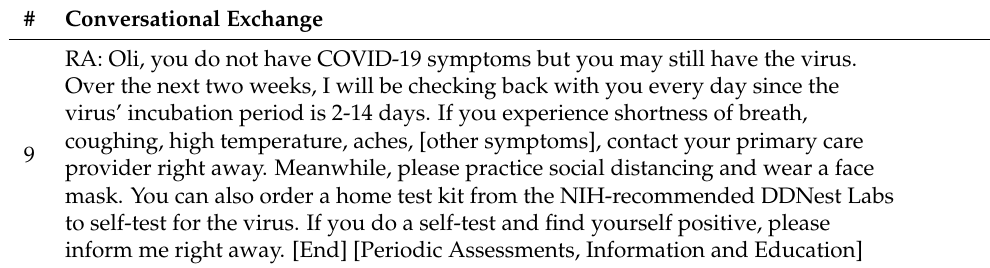
Table A2. Testing Guidance.